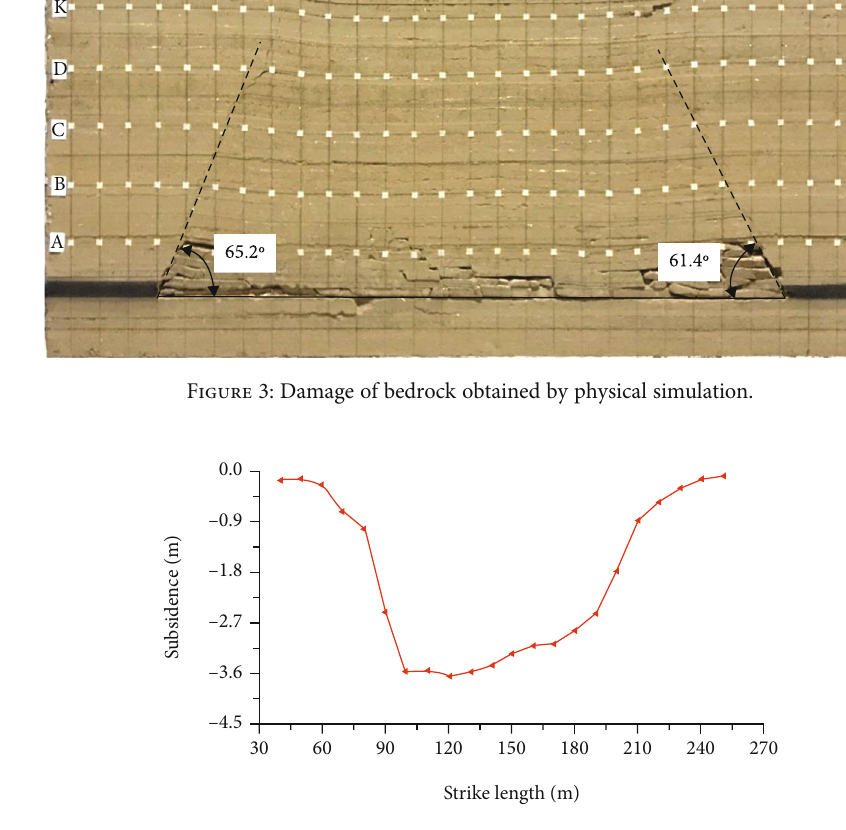
Figure 4: Subsidence curve of bedrock obtained by physical simulation. Table 2: Input parameters obtained by trials and